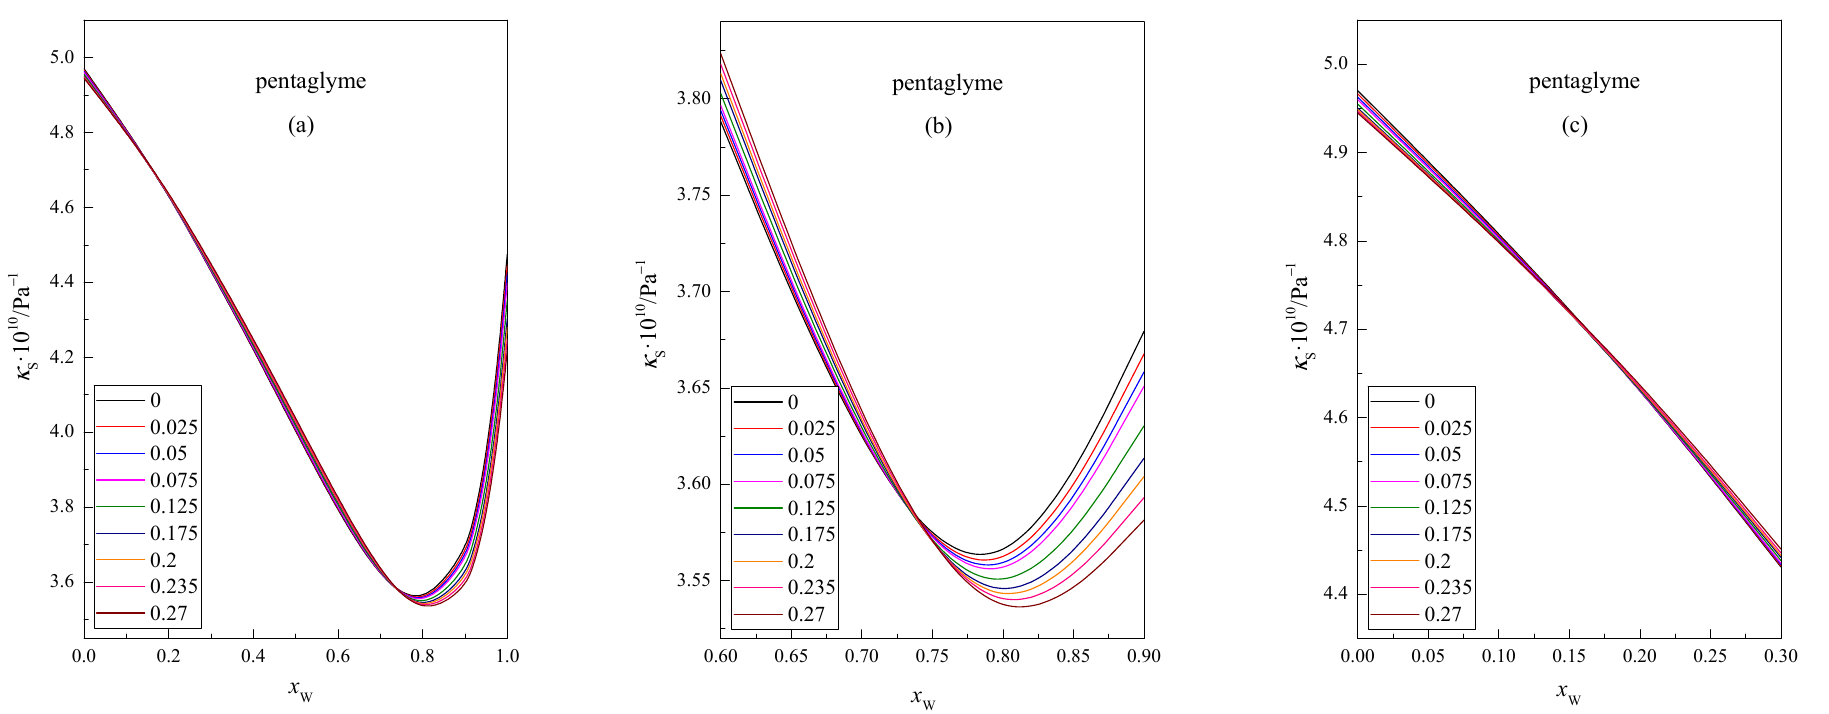
Figure 3. Dependence of the isentropic compressibility κ S of isomolal solutions of pentaglyme in the DMF + W mixed solvent in relation to the mole fraction of water, x W , at 298.15 K, ( a ) 0 ≤ x W ≤ 1, ( b ) 0.6 ≤ x W ≤ 0.9, ( c ) 0 ≤ x W ≤ 0.3.